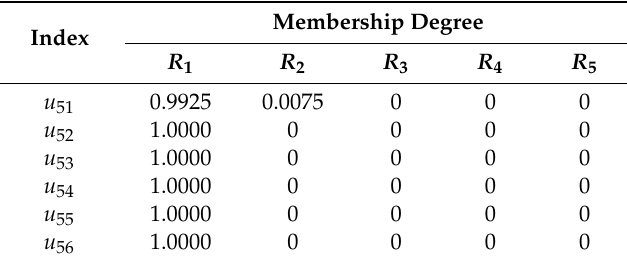
Table 13. Membership degrees of MU influencing factors (R u 5